Question: Looking at the figure, what chart type is it?
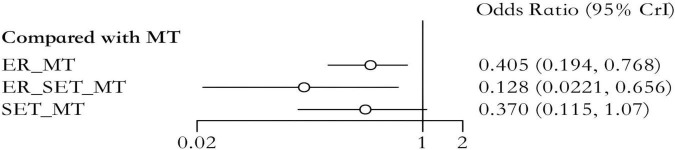
Answer: forest